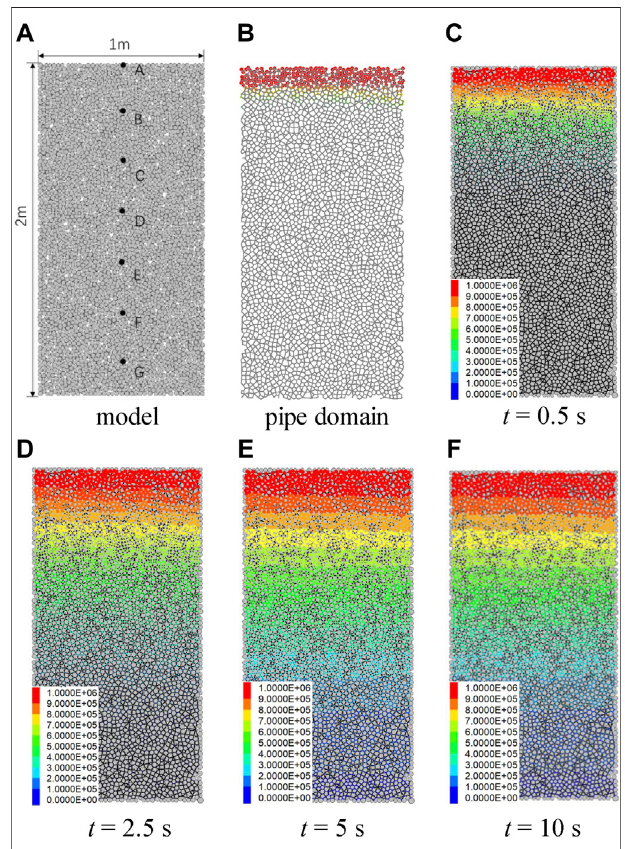
FIGURE 2 | Distribution of seepage pressure in domains at different times under seepage. (A) and (B) are the sample diagram and pipe domain diagram, and (C – F) is the seepage pressure distribution diagram at different